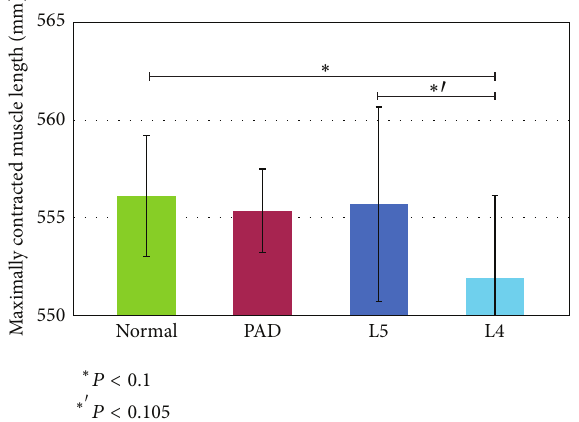
Figure 11: Maximally contracted muscle length of the quadriceps muscle from the reference model.